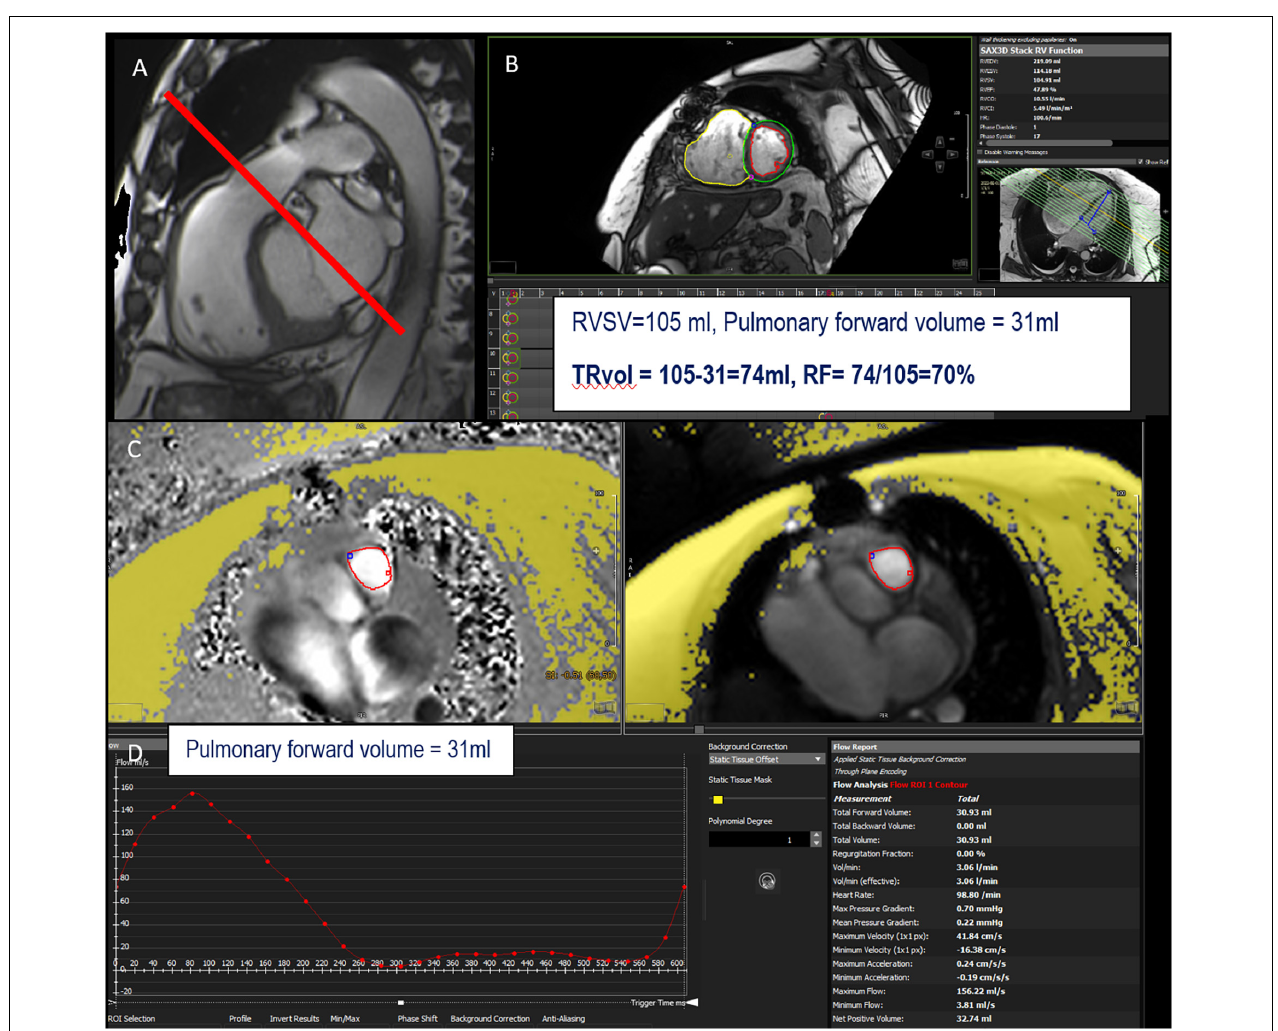
FIGURE 7 | Example of TR assessment using indirect method n ◦ 1. RVOT bSSFP images showing slice position in the pulmonary artery (red line) for phase-contrast velocity mapping to obtain pulmonary forward volume (A) . Assessment of right ventricular stroke volume (RVSV) from short-axis cine SSFP images (B) . Phase and magnitude images with delineation of the pulmonary artery (C) allowing flow curves (D) . This patient has a severe TR with a tricuspid regurgitant volume (TRvol) of 74 ml and a regurgitant fraction (RF) of